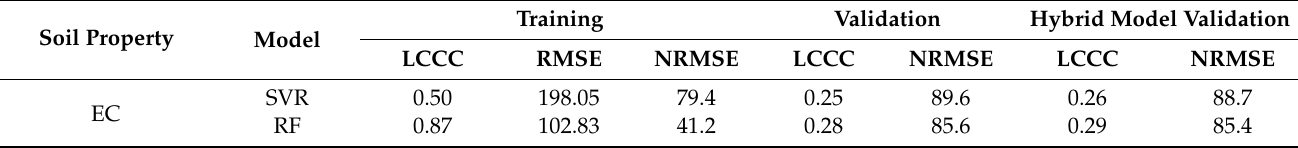
Table 3. Comparison of model performance criteria of different algorithms in predicting EC. Soil